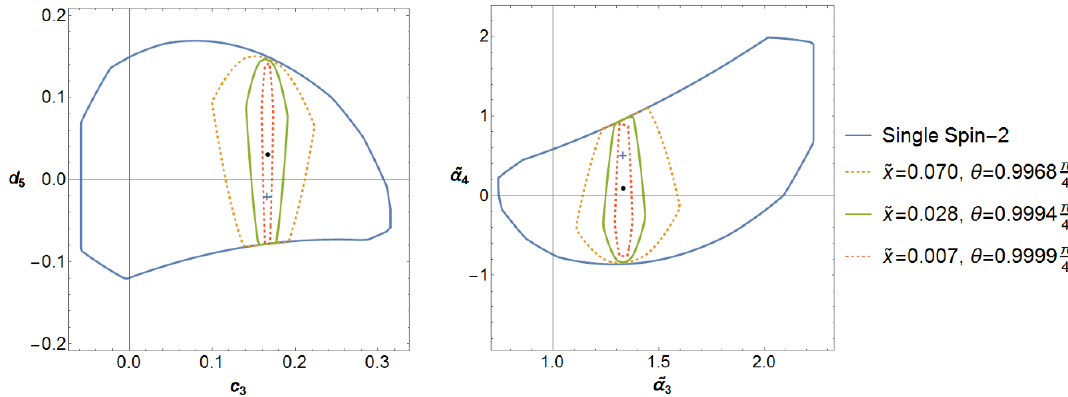
Figure 16 . The allowed regions in the case of (cid:13) = 1 ; ~ (cid:12) 3 = ~ (cid:12) 4 = 0 and di(cid:11)erent values of ~ x (cid:28) 1. Without knowing about the heavy spin-2 state we would have concluded that the allowed region is the single spin-2 region given by the blue contour. However by using this knowledge and subtracting the heavy pole in the application of positivity bounds we (cid:12)nd that the actual region is much smaller. Left: the allowed region in the ( c 3 ; d 5 ) plane, where ~ (cid:11) 3 = (cid:0) 4 c 3 + 2 and ~ (cid:11) 4 = (cid:0) 8 d 5 (cid:0) 4 c 3 + 1. Right: the allowed region in (~ (cid:11) 3 ; ~ (cid:11) 4 )